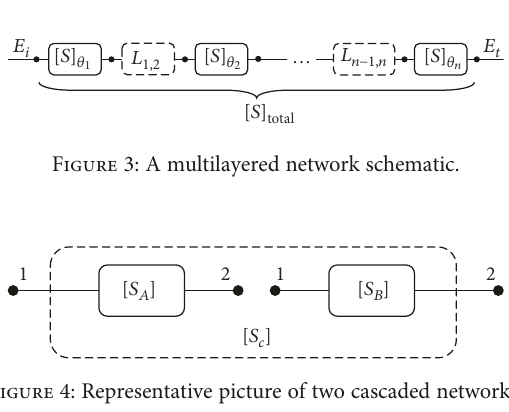
L and (b) Z con fi gurations.